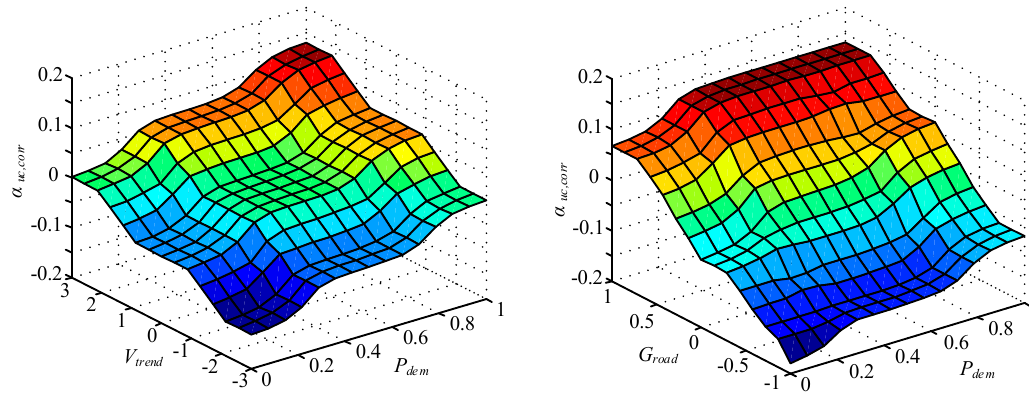
Figure 8. Diagram of fuzzy logic controller.